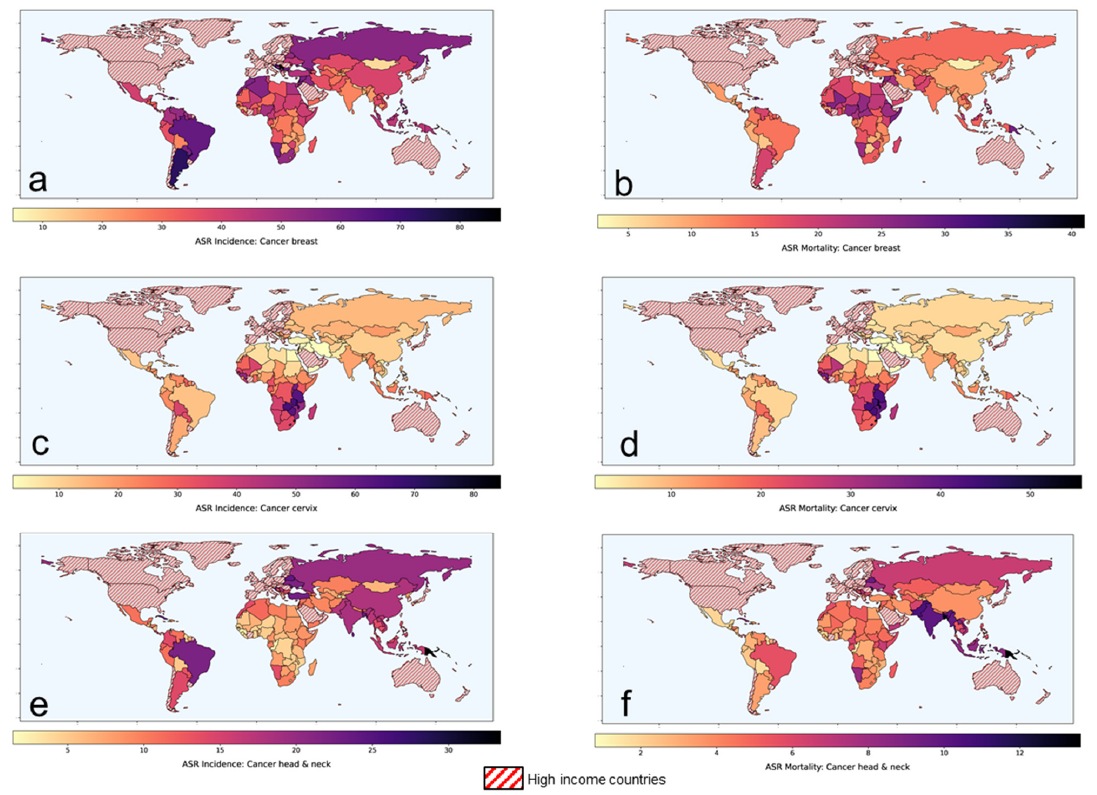
Figure 1. Age-standardized rates of (ASR) for incidence and mortality for ( a , b ) breast cancer ( c , d ) cervical cancer and ( e , f ) head and neck cancers, respectively in low-middle-income group countries. Based on data from Global Cancer Observatory [1].